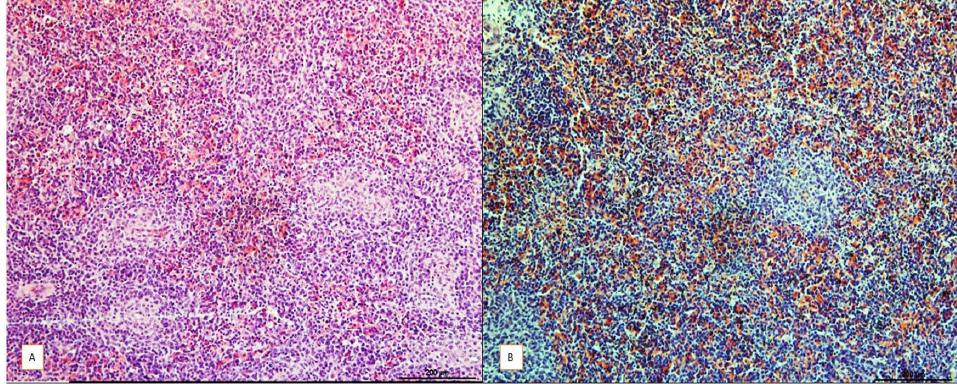
Figure 2. Spleen histology of 21 and 42-year-old birds receiving Rhizomucor spp. in the diet. A: Normal spleen (200 μ m), B: Spleen with diffuse white pulp depletion, moderate with red pulp hyperplasia. (scale: 200 μ m). showed brownish acellular, discrete, and hemosiderin-compatible foci, slight diffuse increase of the red pulp, and moderate diffuse hyperplasia of the white pulp that extended into the red